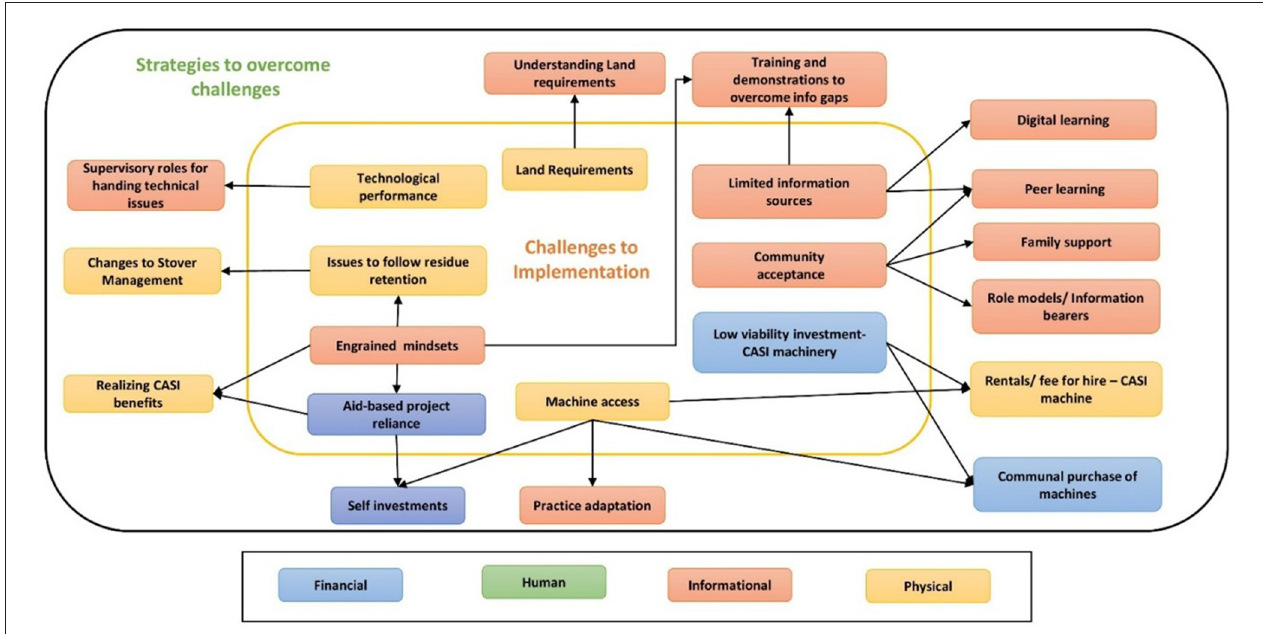
FIGURE 4 | Various challenges to implementation as identified by respondents and strategies employed to overcome